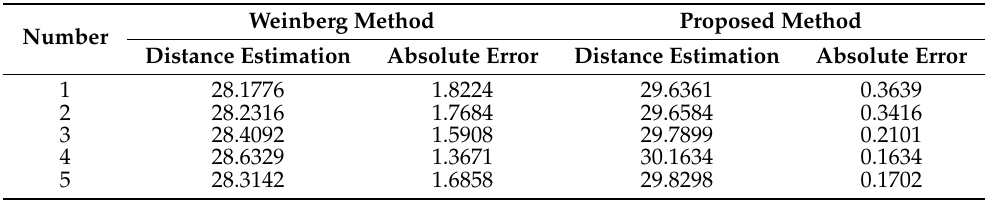
Table 1. Comparison results between the Weinberg method and proposed step length estimation method (m).